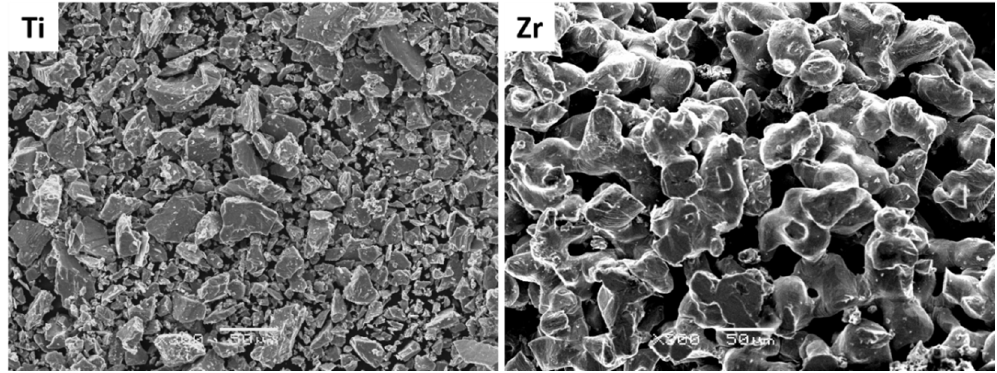
Figure 1. Scanning electron microscope (SEM) micrographs of Ti and Zr initial powders—scale bar 50 μ m.